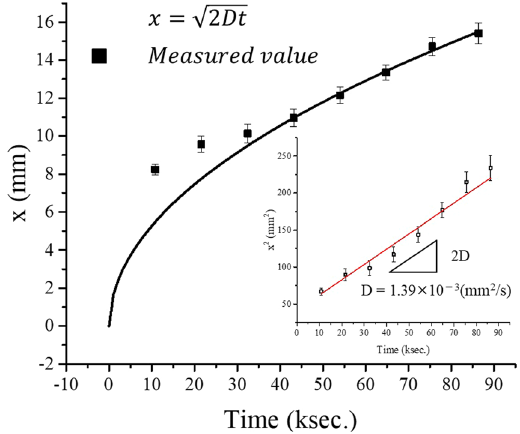
Figure 5. A diffusion distance and time graph during AiS reaction. The black line follows the equation = Dt x 2 using D = 1.39 × 10 − 3 (mm 2 /s). The inset shows a graph for calculating the diffusion coefficient D of protons. The red line is a fitting curve.